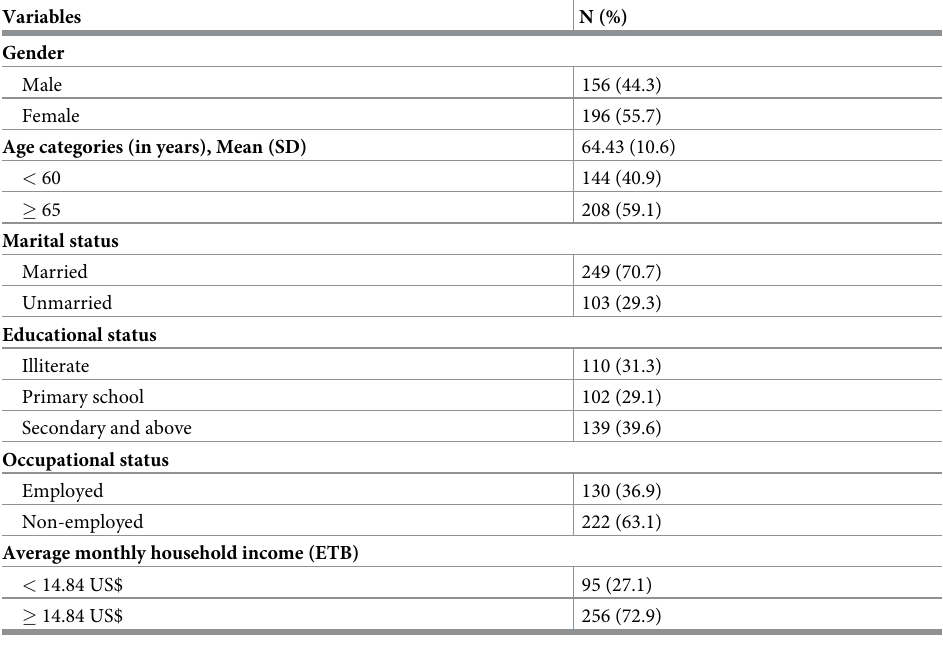
Table 1. Sociodemographic characteristics of the patients with T2DM (N =